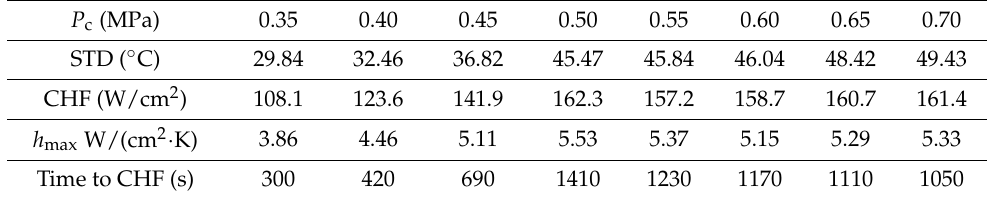
Figure 11. Curves of heat transfer coefficient with time under different refrigerant charges. Table 2. Performance parameters in the dynamic heating